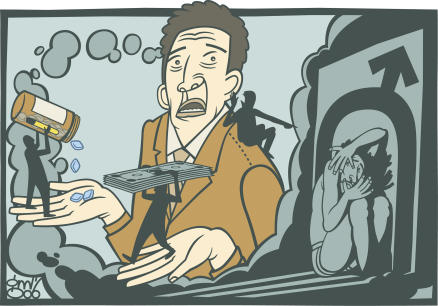
(Illustration: Giovanni Maki)